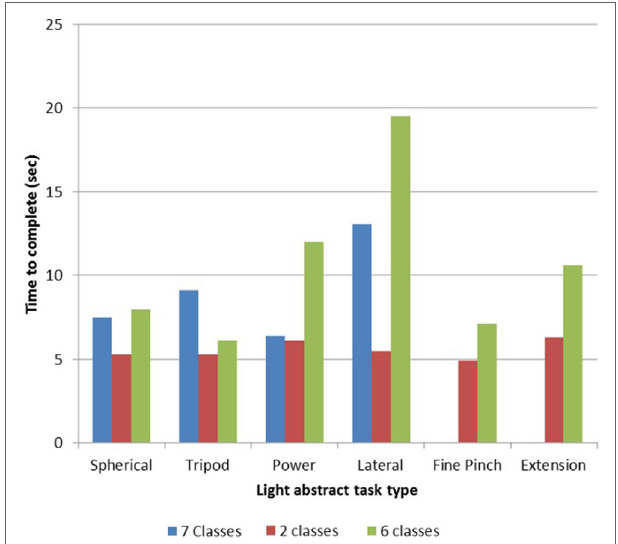
FIguRe 2 | Light object Southampton Hand Assessment Procedure (SHAP) results for TR01. TR01 demonstrated scalable control of the Modular Prosthetic Limb while completing the light object SHAP (13, 20) using sets of two, six, and seven simultaneously controllable motion classes. Completion times were lowest with the two-motion set, which included the motions of hand open and spherical grasp. The six-motion set added wrist flexion/ extension and wrist protonation/supination, while the seven-motion set included fine pinch